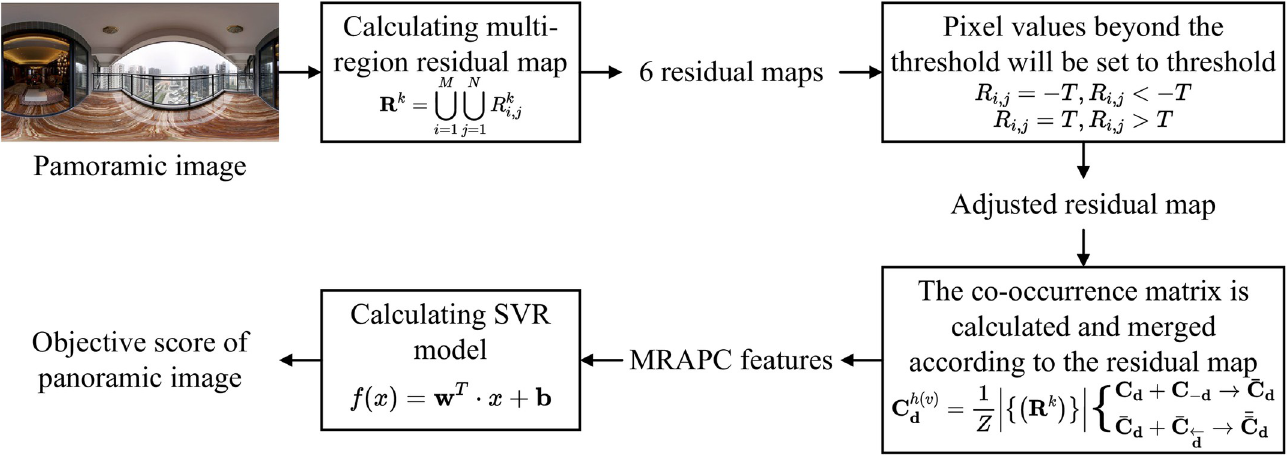
Fig 5. Framework of quality assessment method based on multi-region adjacent pixel correlation